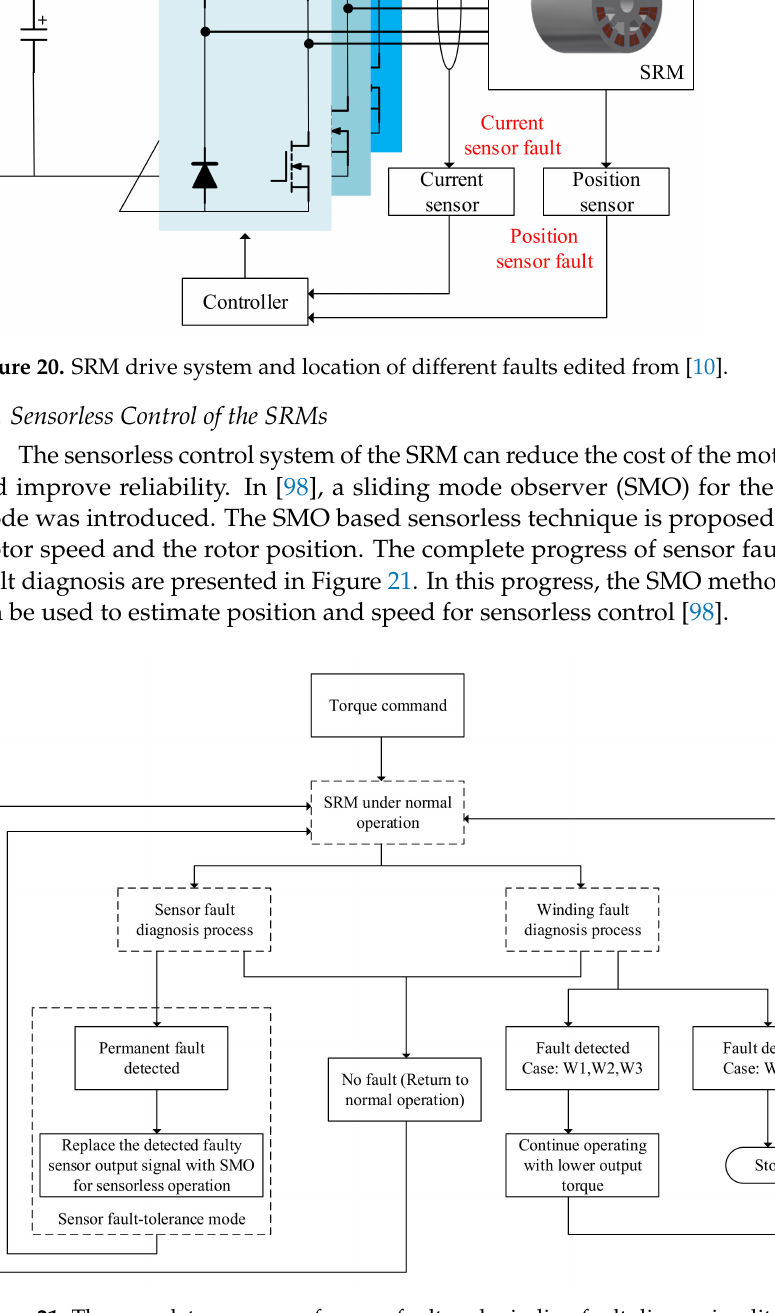
Figure 21. The complete progress of sensor fault and winding fault diagnosis edited from